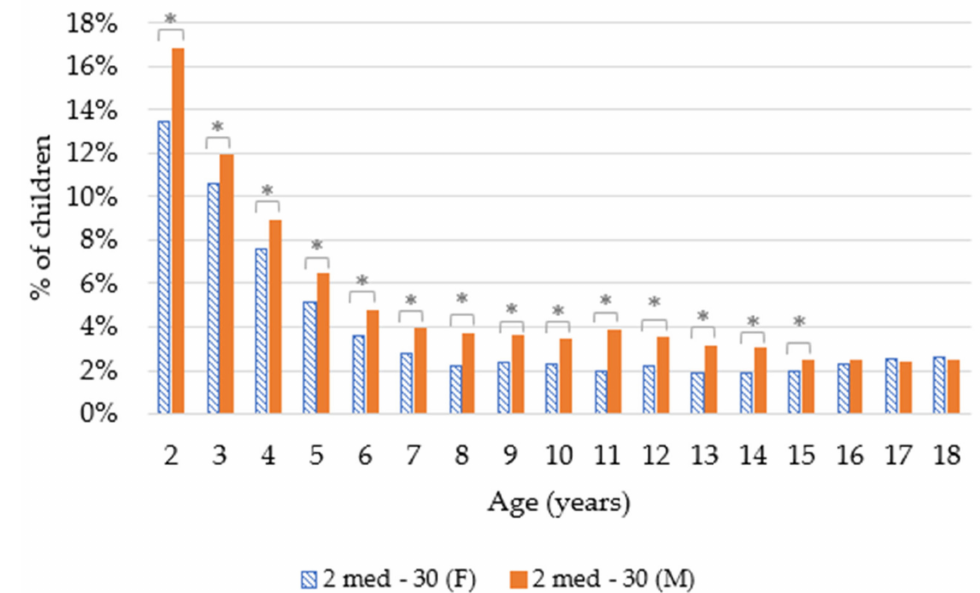
Figure 6. Proportion of children taking asthma medications according to gender (F = female; M = male; 2 med-30 = children with at least two asthma medications with at least 30 days between two purchases; * = the difference between male and female was statistically significant ( t -test with p <